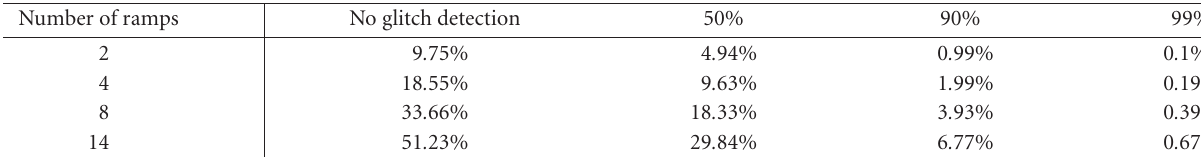
Table 2: Potential loss of scientific data.